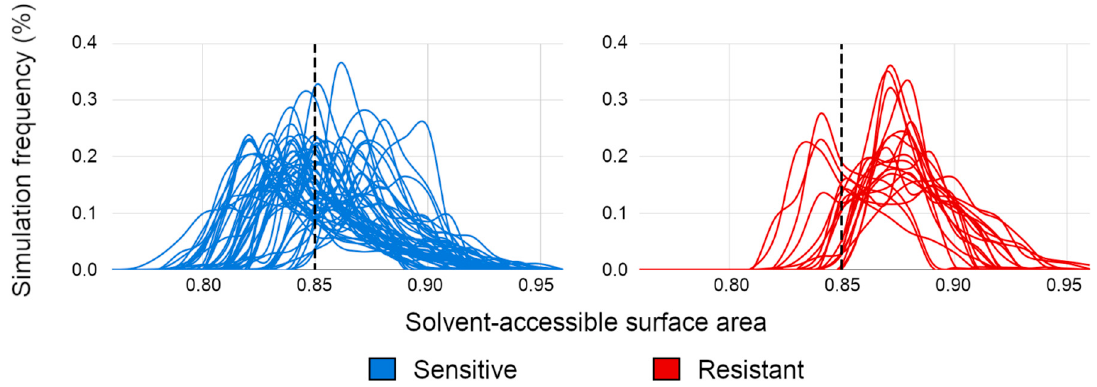
Figure 3. Frequency of solvent-accessible surface area (SASA) determination of PELE simulations in a set of 45 sensitive (blue) and 19 resistant (red) Human Immunodeficiency Virus 1 (HIV-1) gp120 strains. The dashed line indicates a SASA value threshold of 0.85, used for defining a binding and unbinding cut-off event.